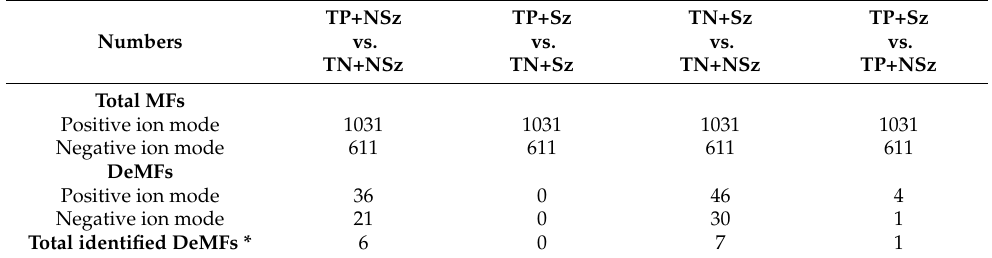
Table 2. Number of total, differentially expressed and identified MFs in different group comparisons.